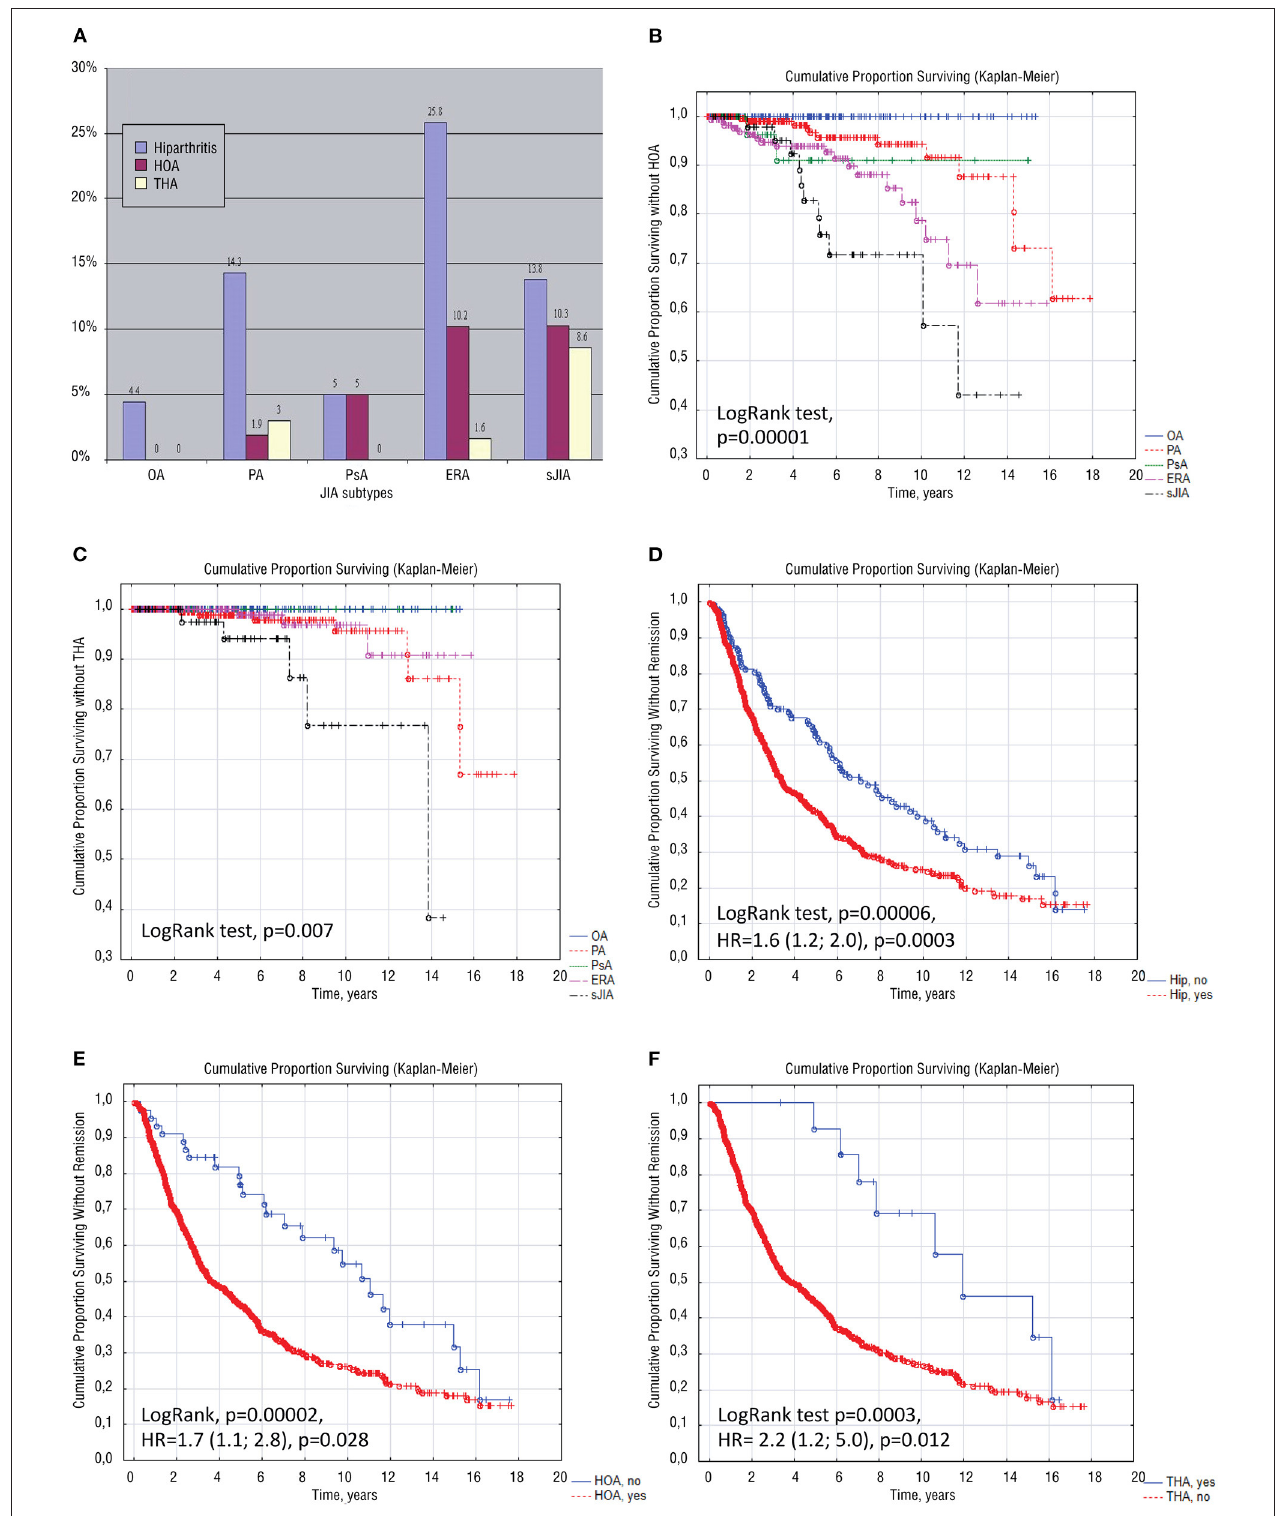
FIGURE 2 | Multiple schemes are depicting the distribution of different types of hip involvement in children with JIA categories (A) , the cumulative probability of surviving without hip osteoarthritis (B) and without total hip arthroplasty (C) in children with distinct JIA categories; Cumulative probability of achievement of remission in JIA depending on the hip involvement (D) , on the development of hip osteoarthritis (E) and depending on total hip arthroplasty (F) . ERA, enthesitis-related arthritis; HOA, hip osteoarthritis; HR, hazard ratio; JIA, juvenile idiopathic arthritis; OA, oligoarthritis; PA, polyarthritis; PsA, psoriatic arthritis; sJIA, systemic JIA; THA, total hip